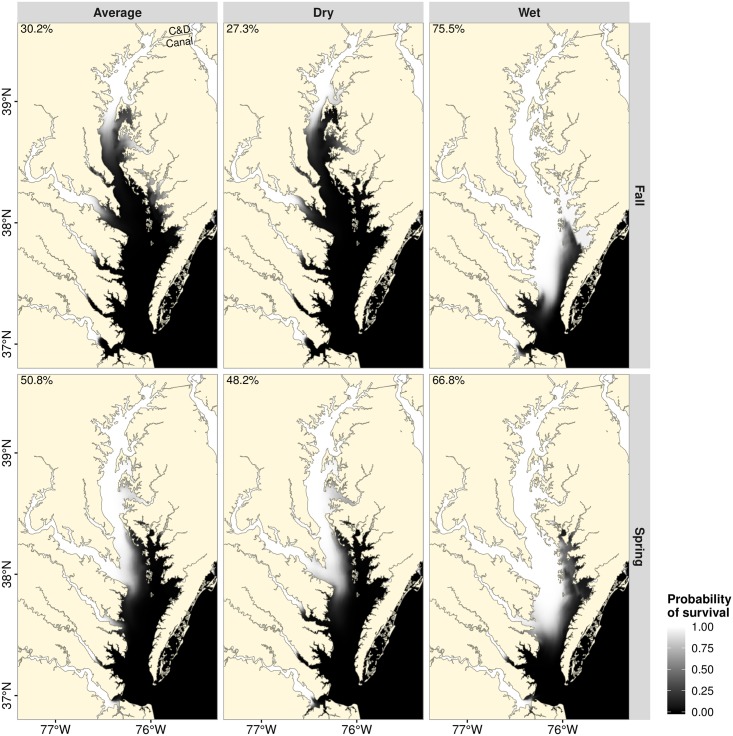
Spatially explicit probabilities of survival for a 224 mm blue catfish throughout the Chesapeake Bay based on surface salinities.See Fig 7 for additional details.